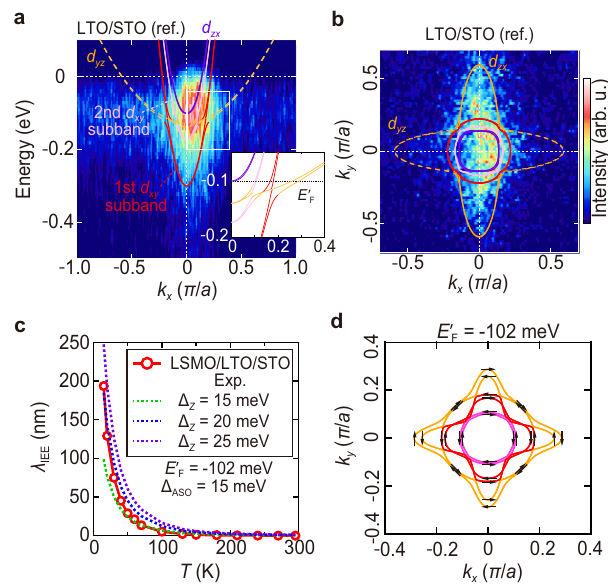
Fig. 4 | R-ARPES measurement results for the band dispersion and Fermi sur- face with the theoretical curves and spin orientations, and a comparison between the experimental λ IEE and theoretical λ IEE . a Band dispersion of a referencesampleLTO(3u.c.)/STOalong k x measuredbyR-ARPES.The2DEGstates areobservedusingtheresonantphotonenergyfortheTi L 3 absorptionedgeofthe Ti 3+ component ( h ν =459.7eV). The solid and broken curves represent the band dispersions calculated by the effective tight-binding model. The inset is the enlarged band dispersion of the calculation near the crossing point of the d xy and d yz bands. The dotted line of the inset corresponds to the Fermi level used for the calculation of λ IEE in the LSMO/LTO/STO sample ( E ’ F = – 102meV). Here, E F and E ’ F are the Fermi levels of LTO/STO obtained by the R-ARPES measurement and the Halleffectmeasurement,respectively(seeSupplementaryNote4). b Fermisurface of the reference sample LTO (3u.c.)/STO obtained by R-ARPES. Although it is not clear,theFermisurfaceofthethinLTOlayer,whichisconsideredtobesmalldueto its small carrier concentration, may be partially overlapped with the Fermi surface ofthe2DEGataroundthecenterofthe k x − k y plane.Inthismeasurement,theFermi surface elongated in the k y direction is visible, but the surface elongated in the k x direction is almost not, due to the experimental geometry of the ARPES measurements 48 . The solid and broken curves are the Fermi surfaces calculated by the effective tight-binding model at E F =0meV. c Temperature T dependence of experimental λ IEE for the LSMO/LTO/STO sample and calculated λ IEE for Δ z =15, 20 and 25meV with Δ ASO fi xed at 15meV. d Calculated Fermi surface and spin expec- tation values (arrows) at E ’ F = – 102meV by the effective tight-binding